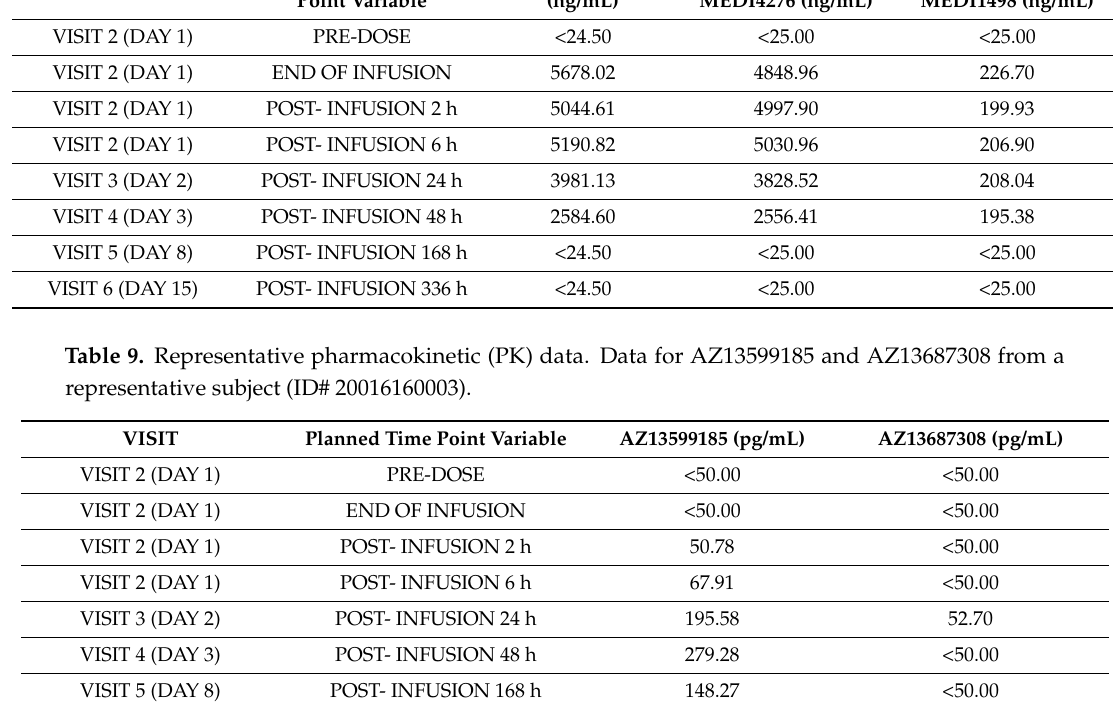
Table S1A: Eluting pump program Assay 1, Table S1B: Make-up pump program Assay 1, Table S1C: Valco valve program Assay 1, Table S2A: Eluting pump program Assay 2, Table S2B: Trapping pump program Assay 2 and Assay 3, Table S2C: Make-up pump program Assay 2, Table S2D: Valco valve 1 program Assay 2, Table S2D: Valco valve 2 program Assay 2, Table S2D: Valco valve program Assay 3, Table S3A: Eluting pump program Assay